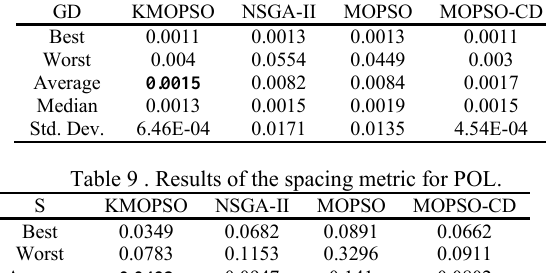
Fig. 8. Box plots for the metrics of generational distance (a), Table 8 . Results of the generational distance metric for POL.